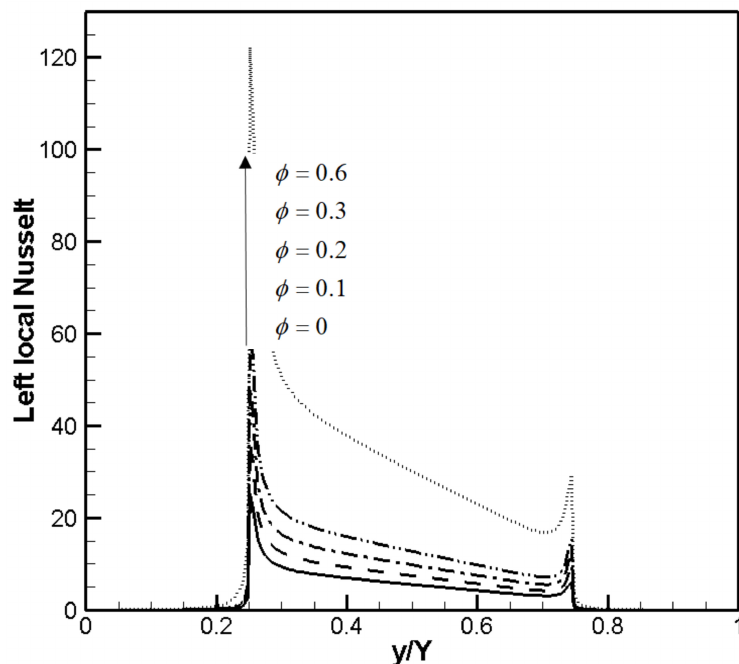
Figure 8. Variation of left local Nusselt number along the left boundary (Cu-water nanofluid) for different volume fractions ( φ ) (case 1) at Ra = 10 5 .